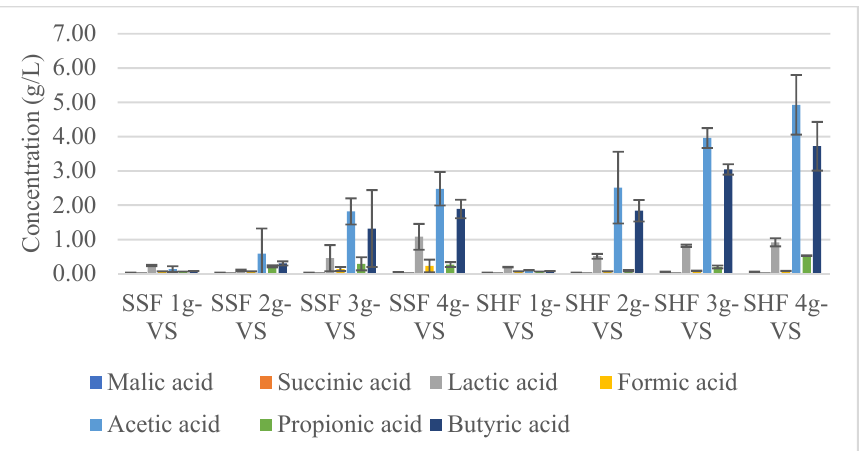
Figure 1. Comparisons of soluble metabolite products from SSF and SHF of two-stage hydrogen and methane production using DES-pretreated sugarcane leaves at different loading substrates.